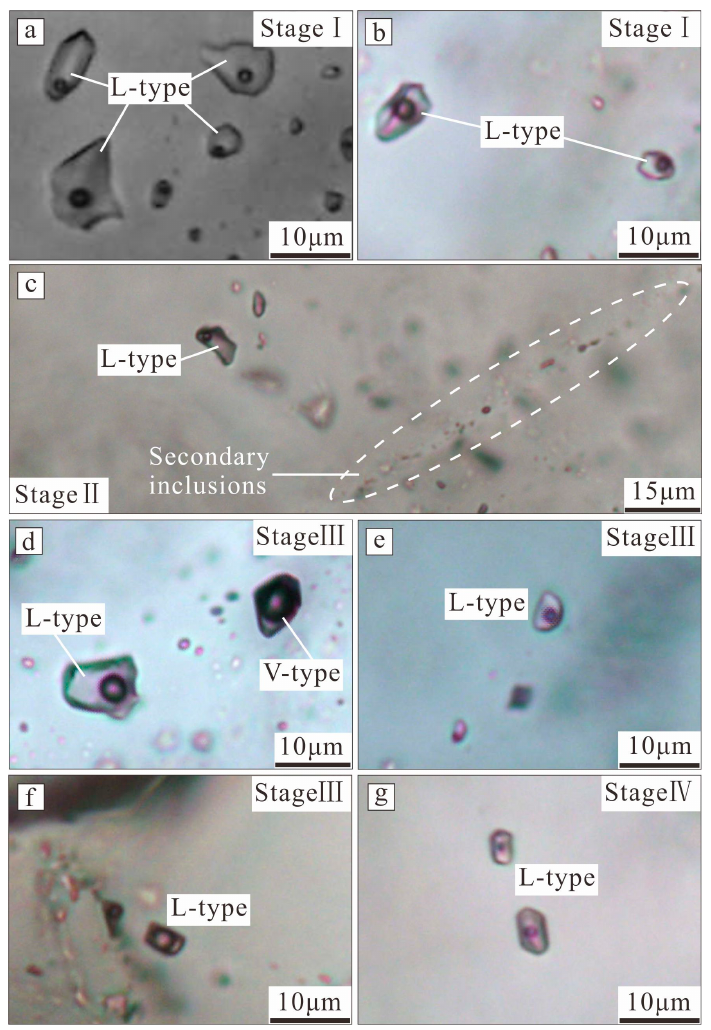
Figure 6. Photomicrographs of fluid inclusions in Stages I–IV in the Chuduoqu Pb-Zn-Cu deposit. ( a ) L-type inclusions in Stage I quartz; ( b ) L-type inclusions in Stage I quartz; ( c ) L-type inclusions in Stage II quartz; ( d ) Coexisting V-type and L-type fluid inclusions in Stage III quartz; ( e ) L-type inclusions in Stage III quartz; ( f ) V-type inclusions in Stage III quartz; ( g ) L-type inclusions in Stage IV quartz.